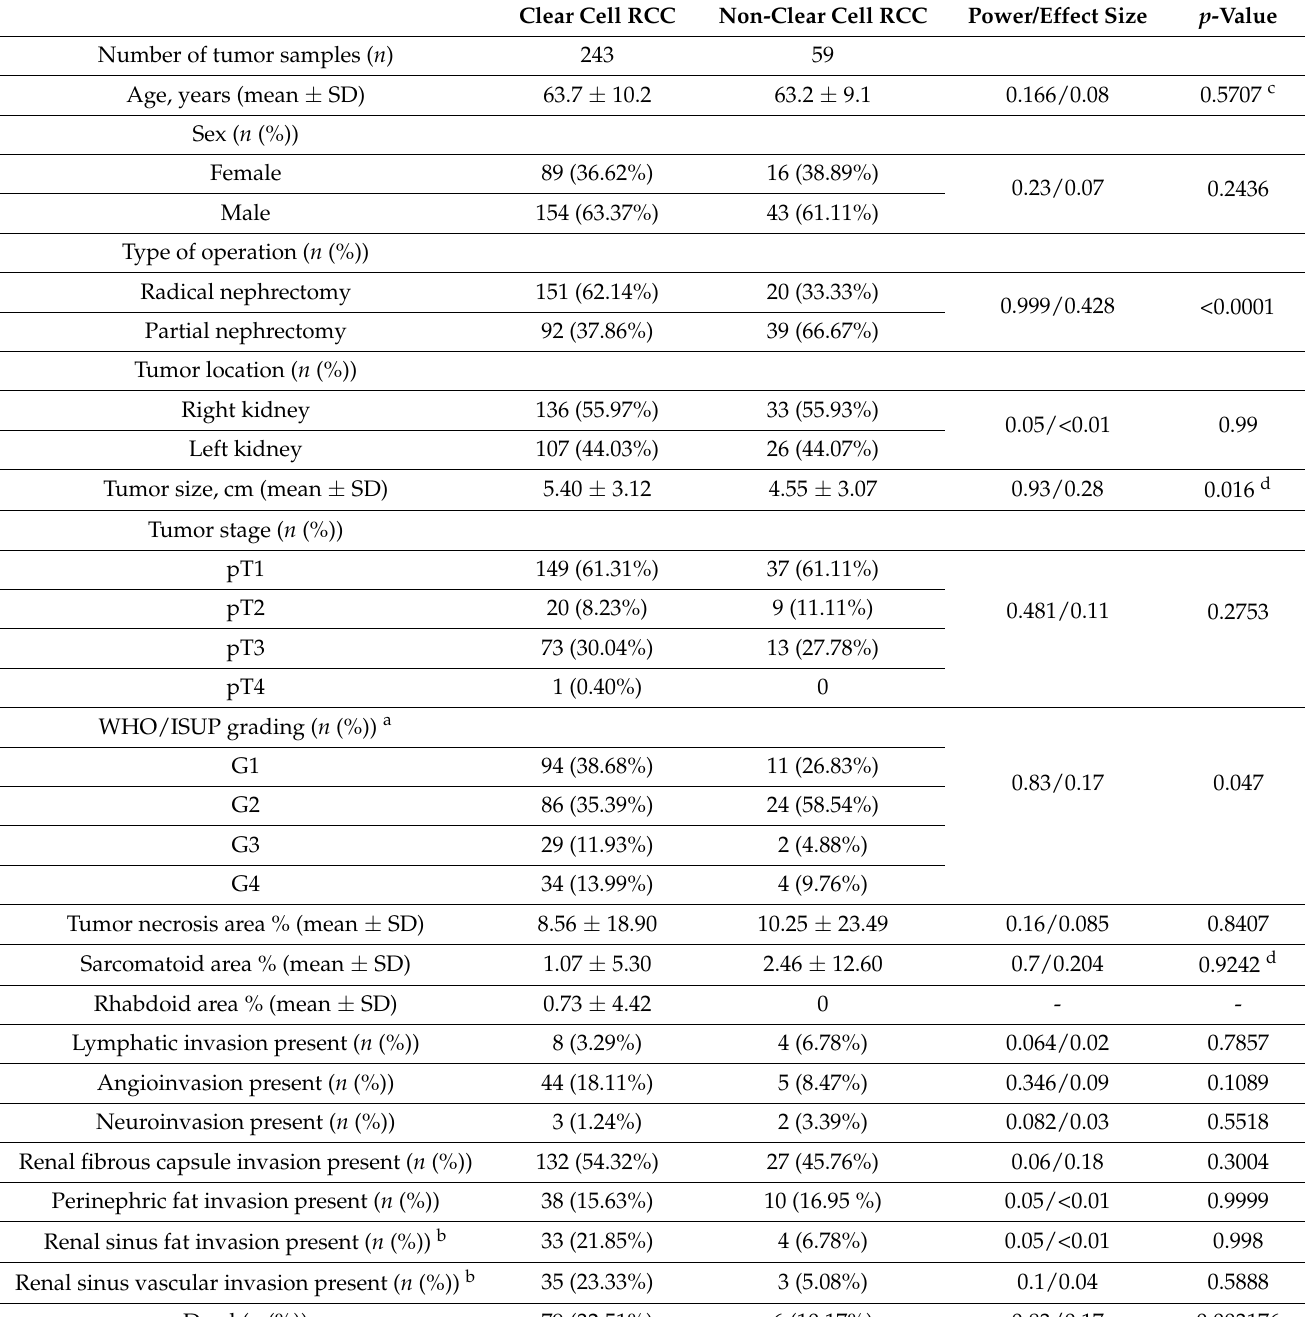
Table 2. Comparison of the clinicopathological characteristics of clear-cell and non-clear-cell renal cell carcinoma